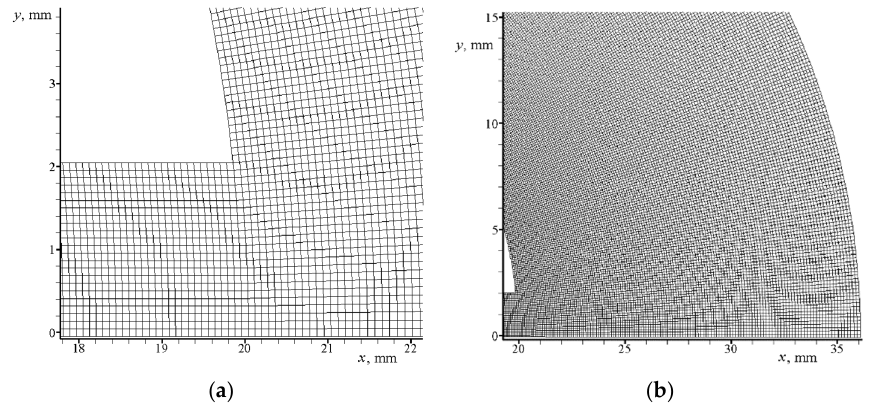
Figure 3. Difference grid: ( a ) in the vicinity of the channel outlet into the slot space; ( b ) in the slot space.